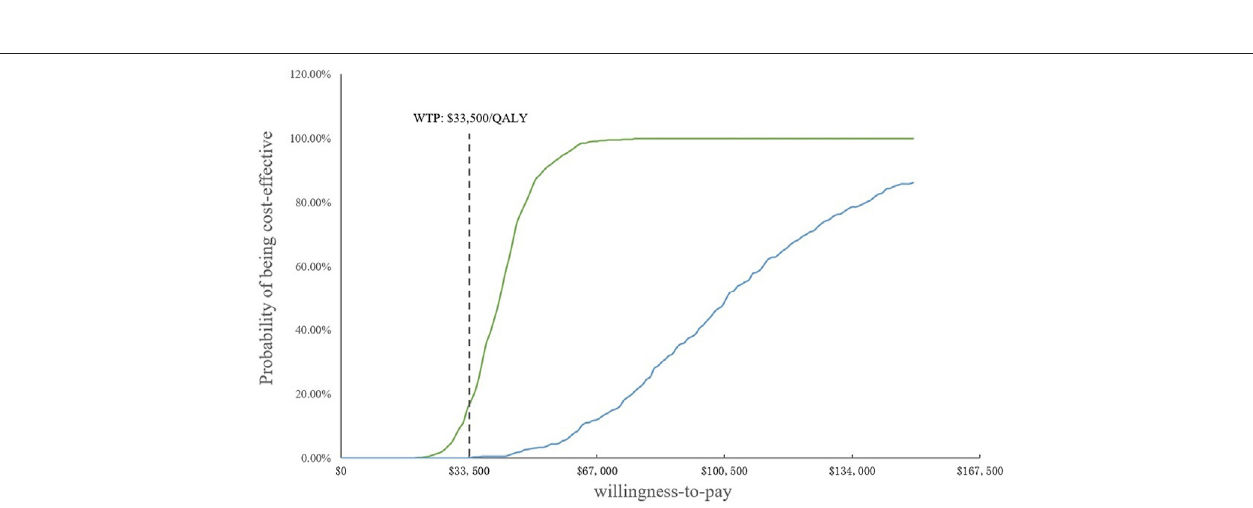
Frontiers in Pharmacology |